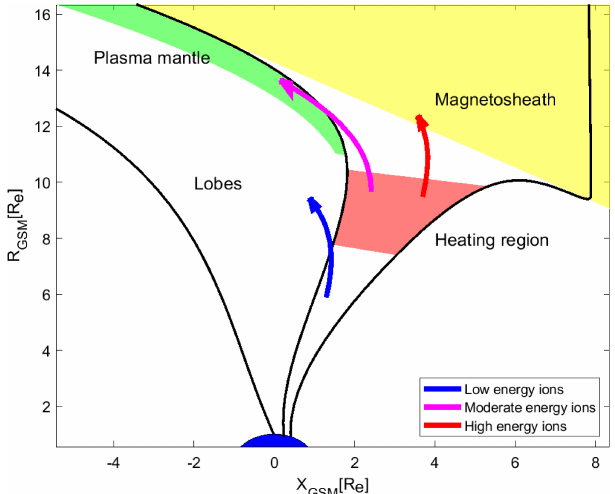
Figure 3. Paths of oxygen ions based on their energies. The heating region in the high-altitude cusps as well as lobe and magnetosheath regions are included.